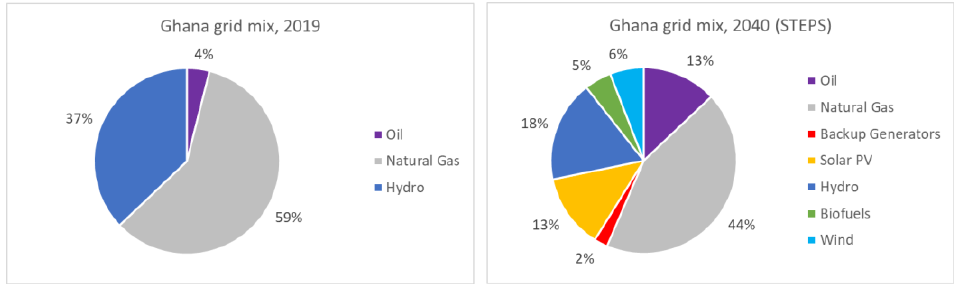
Figure 4. Current [58] and future electricity grid mix compositions for Ghana, with the latter based on IEA “STEPS” scenarios [58]. Note: Numbers may not add up to 100% due to rounding.